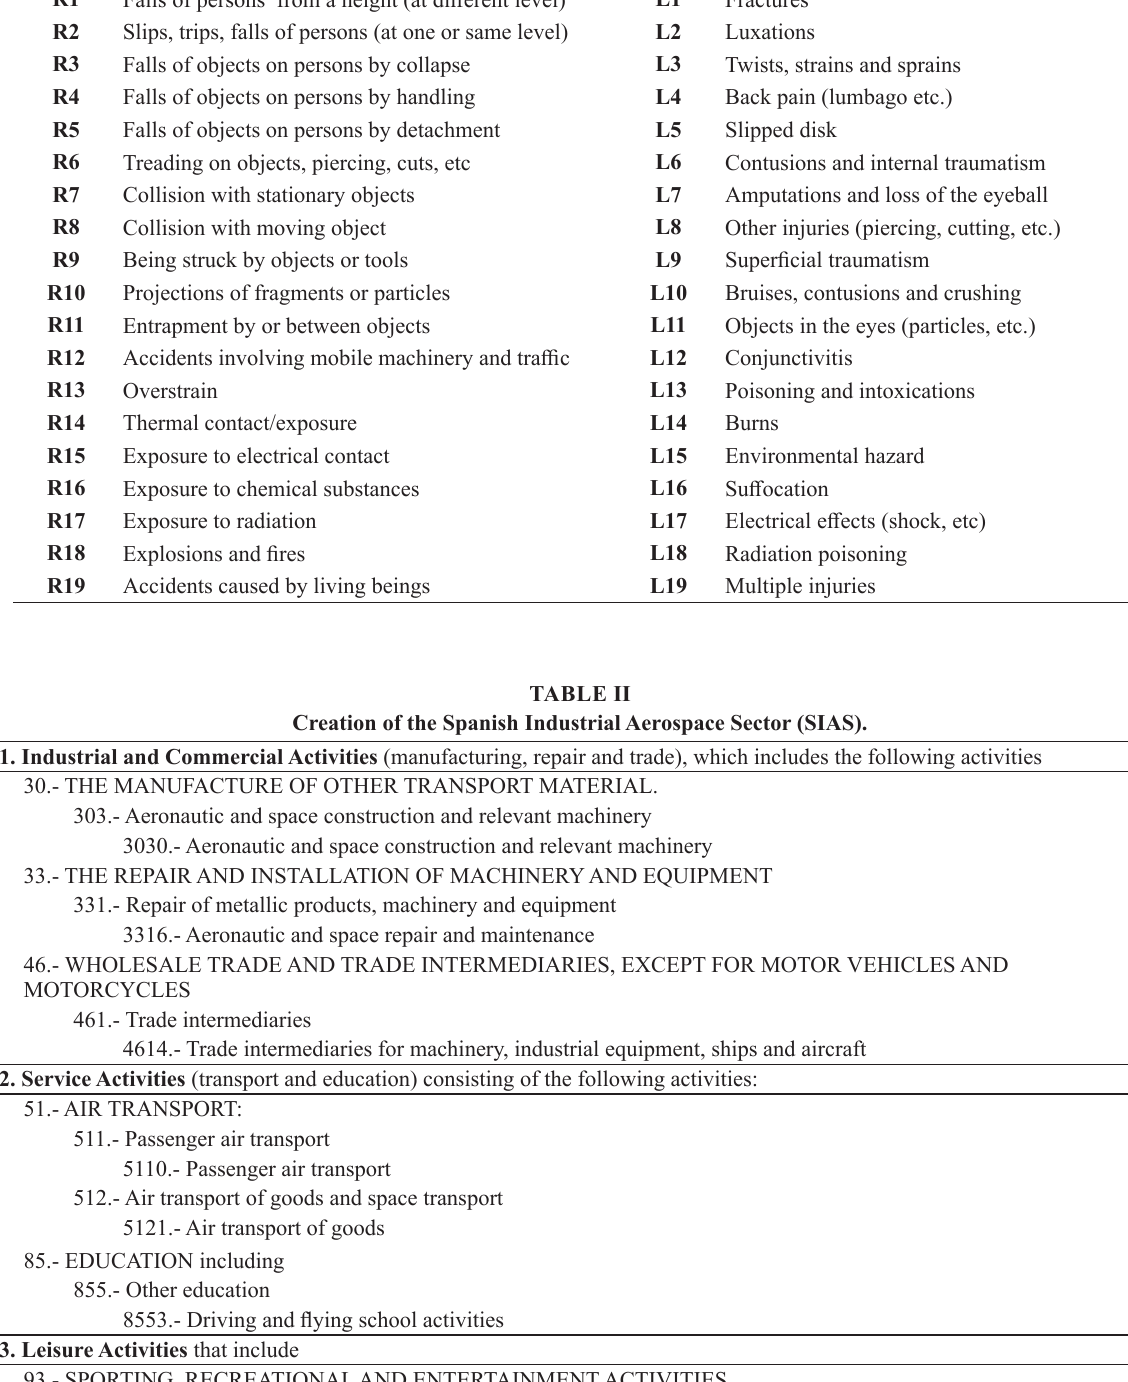
The 19 selected Risks and Injuries from the ILO classification. CODES OF RISKS CODES OF INJURIES